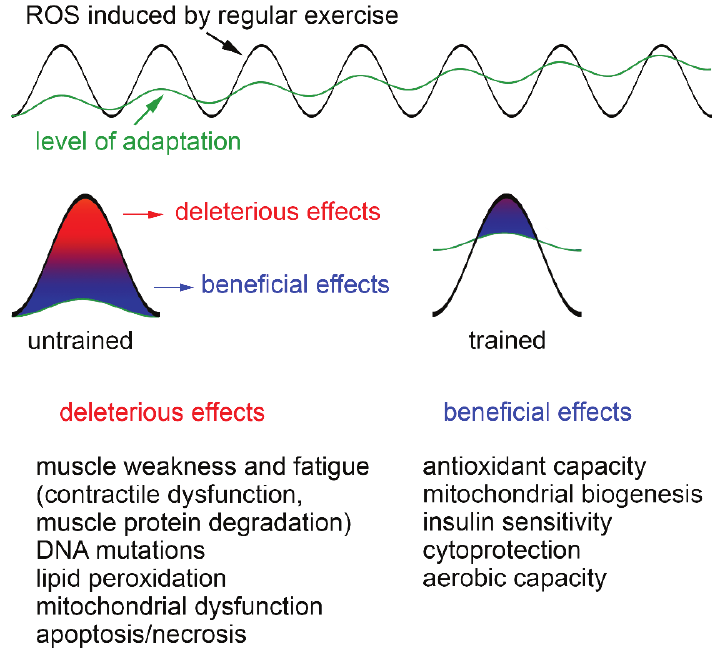
Figure 2. Deleterious and beneficial effects of exercise-induced ROS increase.